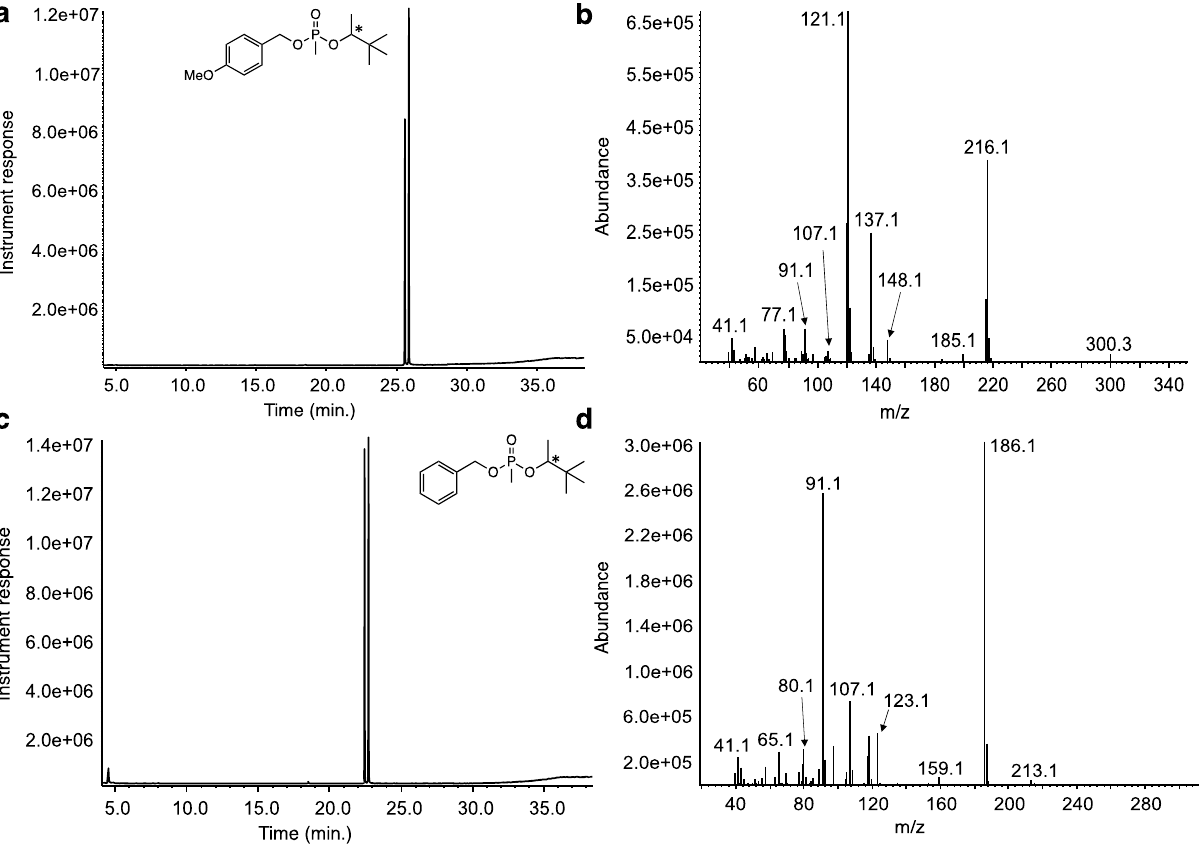
Figure 4. GC–MS traces and associated mass spectra for PMB-PMPA and BPMPA. The GC–MS data was gathered on synthesized standards. Note the resolution of both diastereomers of PMPA by the column as a result of the two stereogenic centers in the molecule, the P atom and the C atom in the pinacolyl arm marked by an asterisk (*).